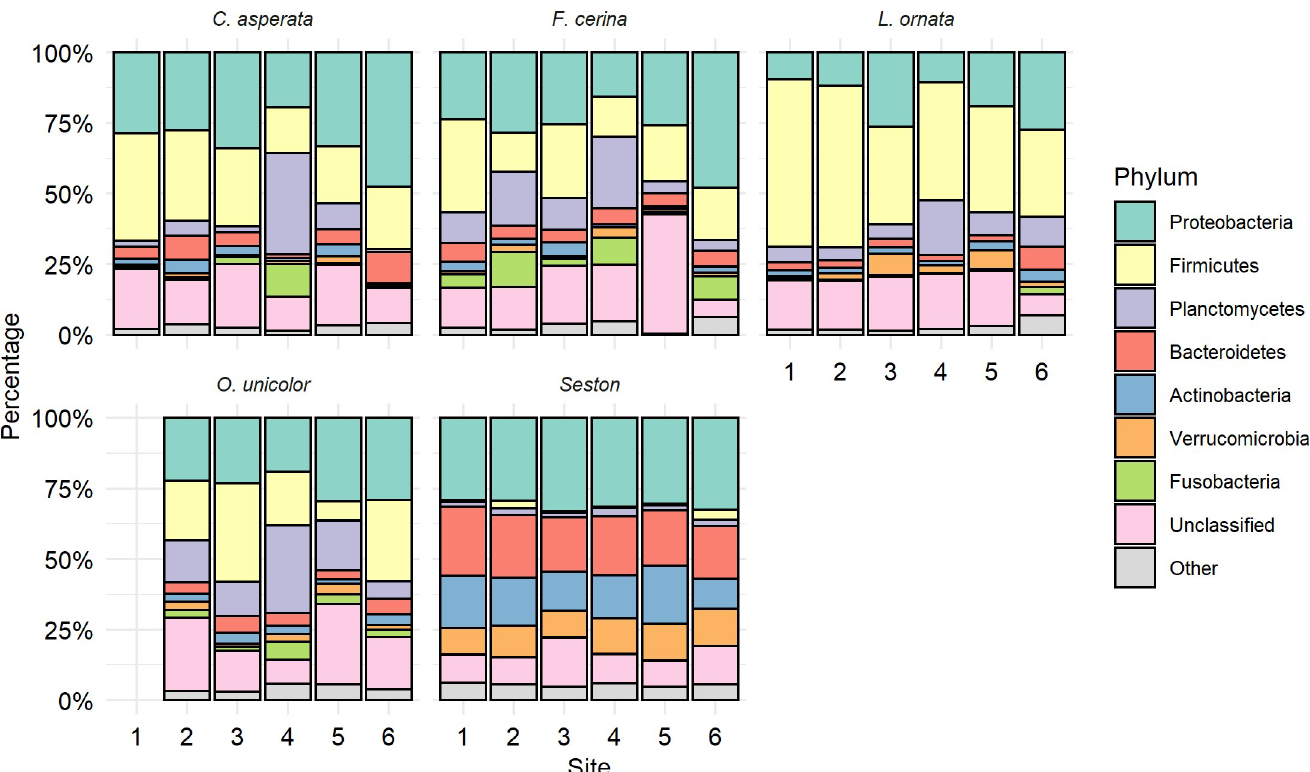
Fig 2. Major bacterial phyla in the gut microbiome of four freshwater mussel species (in order shown: Cyclonaias asperata , Fusconaia cerina , Lampsilis ornata , and Obovaria unicolor ) at six sites in the Sipsey River, AL, USA, and for suspended seston collected from the same sites, as determined by Illumina 16S rRNA gene sequencing. Stacked bar plots are arranged with the most abundant phylum overall (Proteobacteria) at the top. No O . unicolor samples were found at site 1. The seven most abundant phyla are shown and represent 80% of all sequencing reads. Unclassified sequences made up 16% of the total dataset. All other bacterial phyla are grouped together as “other.” Each of the phyla shown differed significantly in relative abundance between the mussel gut and overlying seston with the exception of Proteobacteria.